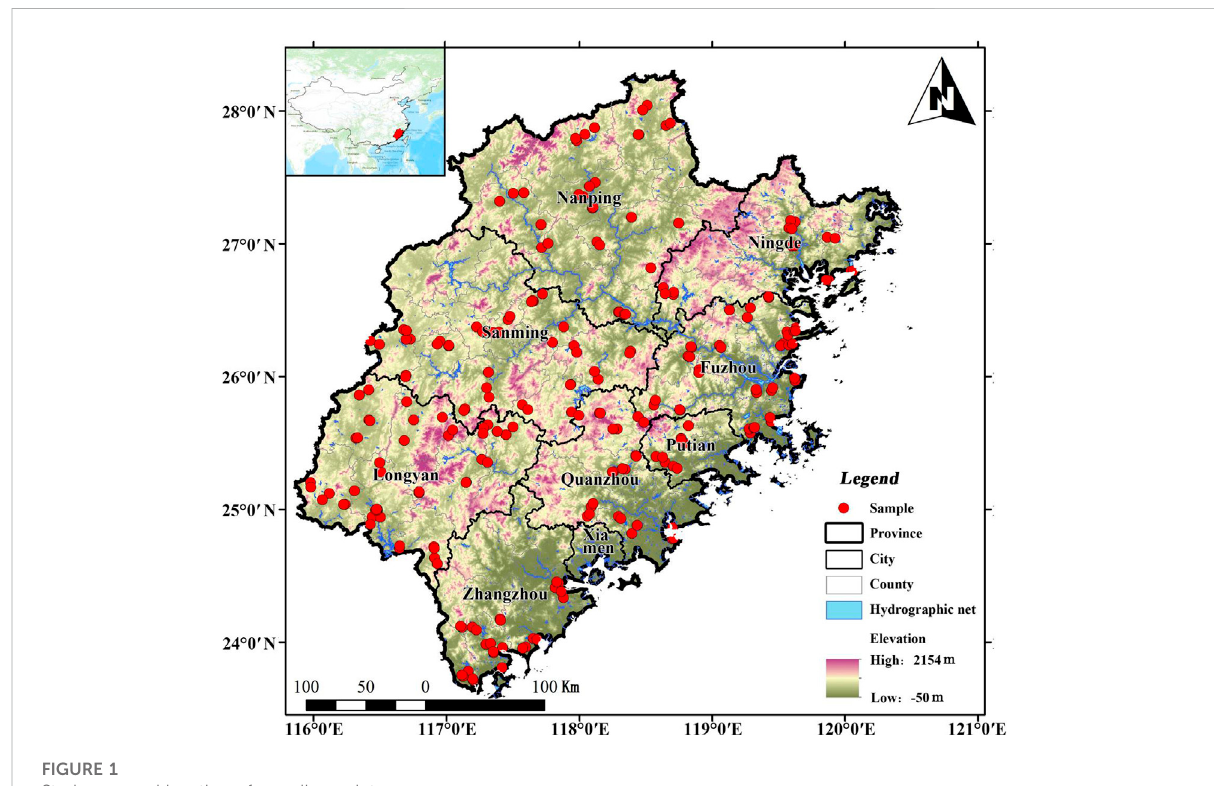
FIGURE 1 Study area and location of sampling